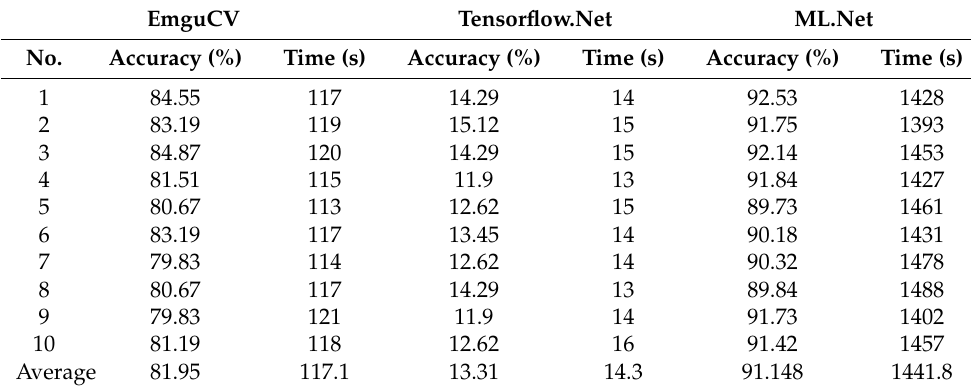
Table 1. Overall accuracy of the